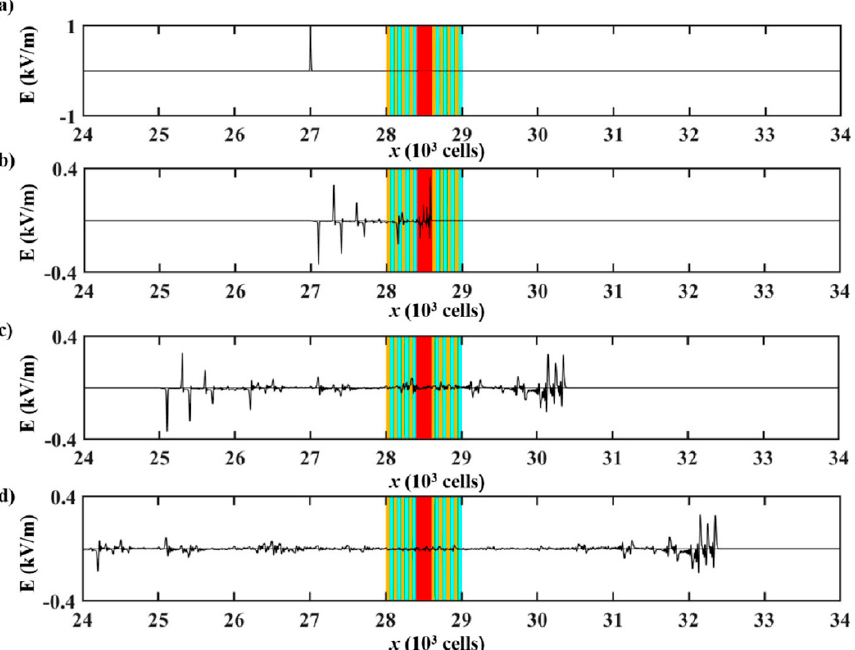
Figure 10. Snapshots of the electric field of an incident Gaussian pulse propagating in air and inci- dent upon a 1D plasma PhC with a defect layer permeability of 6.0 at different times: ( a ) 0, ( b ) 15.3, ( c ) 30.6, and ( d ) 45.9 fs. The properties of the plasma layer are ω p = 2.0 THz, ϑ c = 50 GHz.